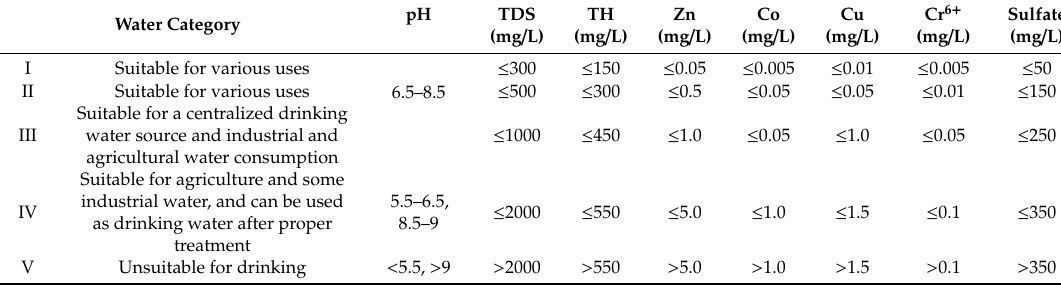
Table 4. Groundwater quality index scale (GB / T